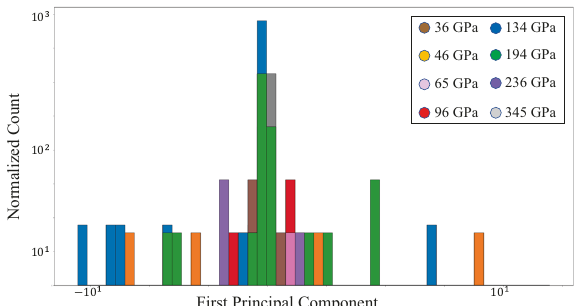
Fig. 4 PageRank clustering of liquid Li structures. The distribution of the fi rst PCA component of various liquid Li phases, was calculated originally from the PageRank algorithm. Each color represents a unique liquid phase. Large gaps exist between bins due to the relatively discrete predictions made by